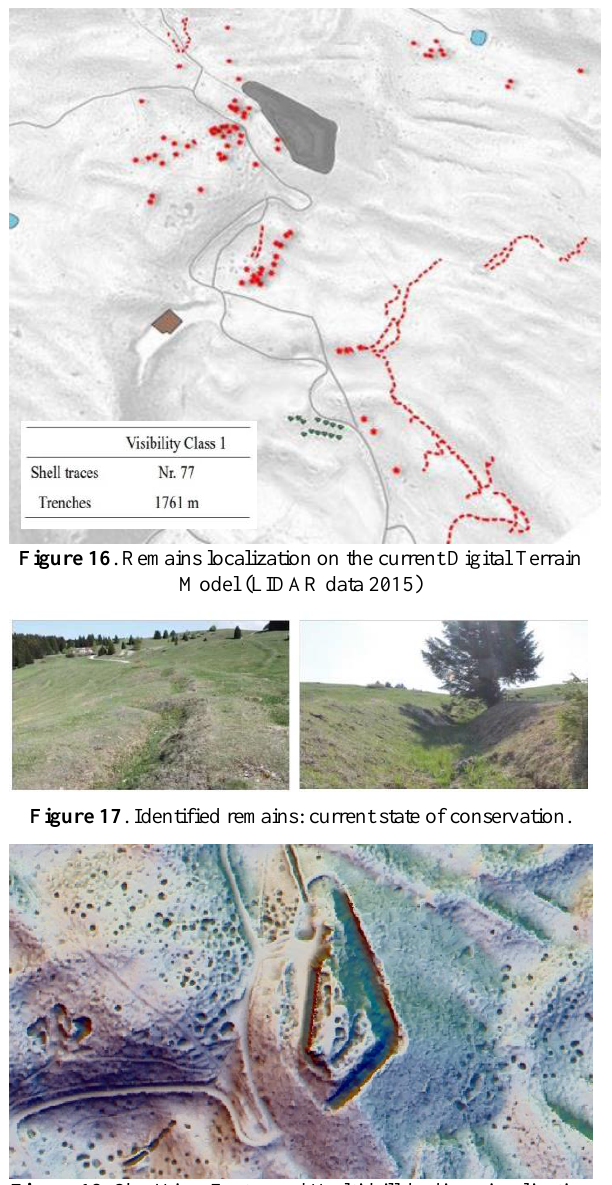
Figure 15 . Identification of major concentrations of the Great War remains